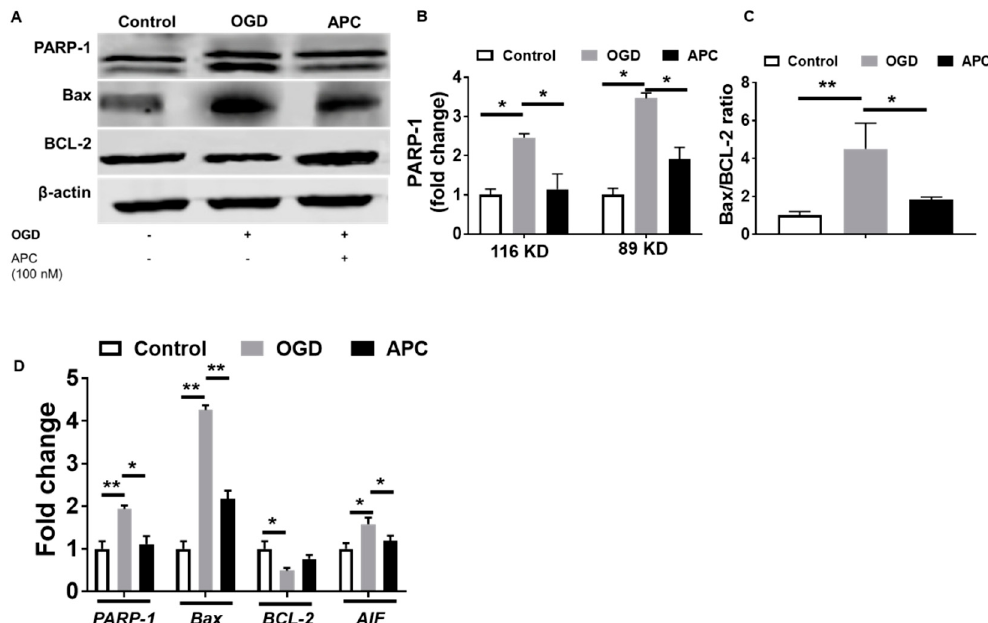
Figure 5. Changes in the expression of protein and mRNA. ( A ) Representative western blots showing the effect of activated protein C (APC) on B-cell lymphoma 2 (BCL-2), BCL-2-like protein 4 (Bax), and Poly(ADP-ribose) polymerase 1 (PARP-1) expression ( n = 4). ( B ) The bar graph shows that APC down-regulated PARP-1. ( C ) Bar graph showing Bax / BCL-2 ratio following OGD exposure with and without APC. The expression of BCL-2, Bax, and PARP-1 was normalized to the expression of β -actin. ( D ) Relative mRNA expression of BCL-2, Bax, PARP-1, and apoptosis-inducing factor (AIF) in SH-SY5Y cells. The data represented are the fold changes ± SD of three separate experiments, * p ≤ 0.05; ** p < 0.01.